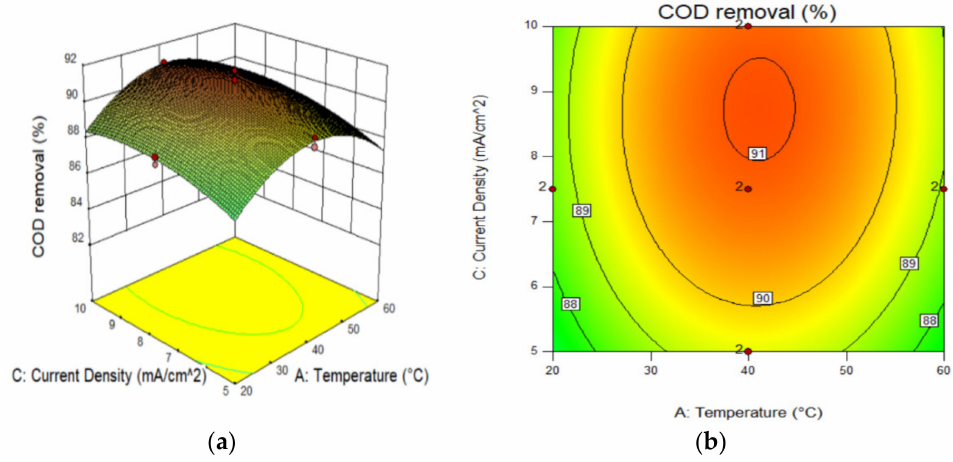
Figure 6. ( a ) Three-dimensional (3D) response graph and ( b ) contour plot for the effect of temperature and current density.